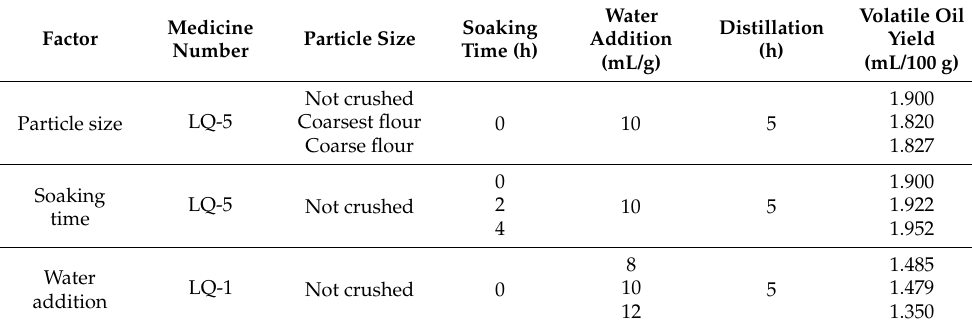
Table 5. Single-factor experiments.